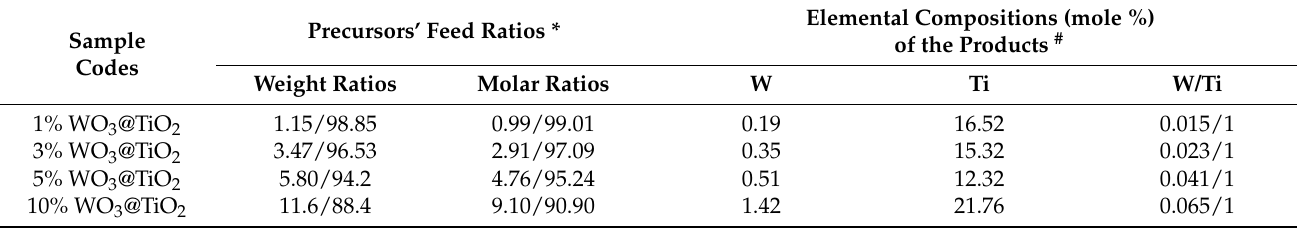
Table 6. Compositions of the various WO 3 @TiO 2